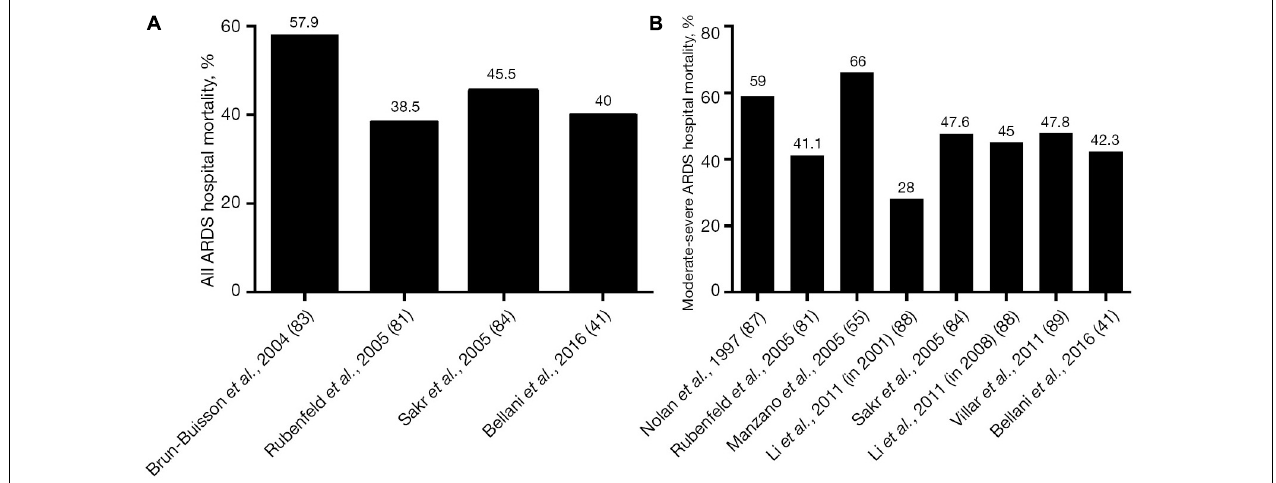
FIGURE 1 | (A) Hospital mortality (%) in the main epidemiological studies for all three American-European Consensus Conference (AECC) classifications of acute respiratory distress syndrome (ARDS – mild, moderate, and severe) and (B) mortality (%) for only moderate and severe ARDS. The mean and standard deviation for mortality in all of the studies following the 2000 ARMA study (Acute Respiratory Distress Syndrome Network, 2000) is 45.4 ± 9.5 (Rezoagli et al., 2017). Permissions obtained from AME Publishing Company, License ID 1017423-1.